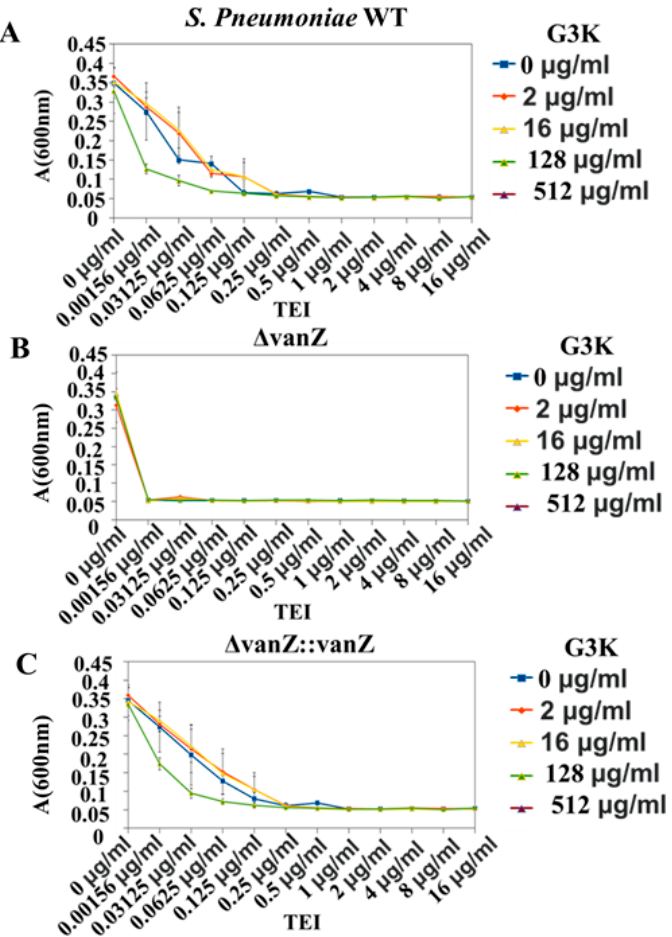
Figure 8. Effect of G3K on VanZ-mediated teicoplanin (TEI) resistance in S. pneumonia R6 . ( A ): S. pneumoniae with knockout and complemented vanZ was used as the control. ( B ): ∆ vanZ positive control strain was used, which showed high sensitivity towards TEI. ( C ): WTs and vanZ -reverted strains were used with G3K, where they increased the sensitivity of the strains to TEI. Data represent the mean ± SD, n =